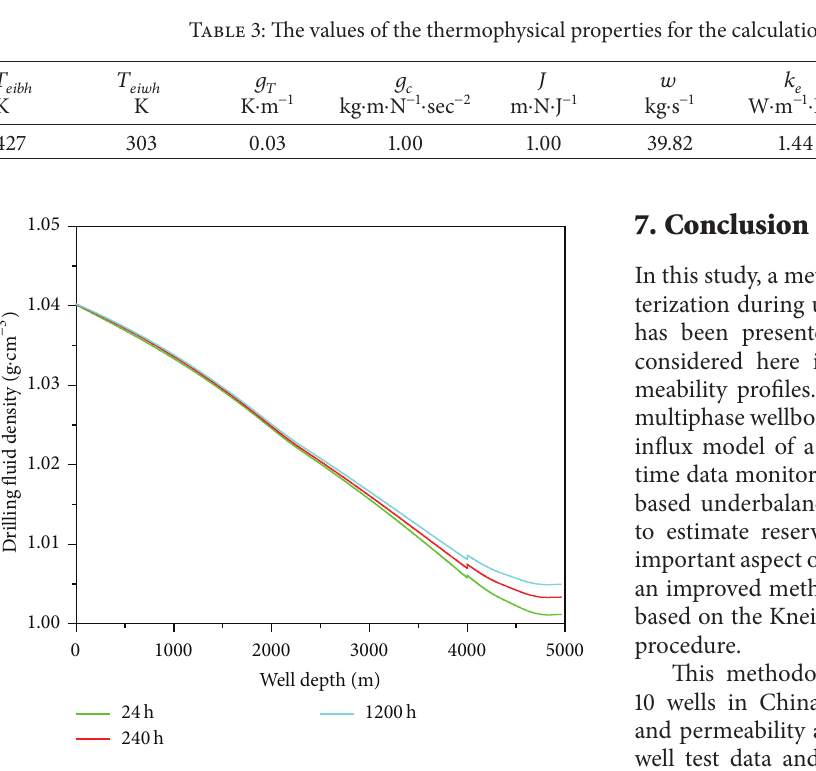
Figure 20: Drilling fluid density profile simulated using new wellbore flow model for different circulation time.